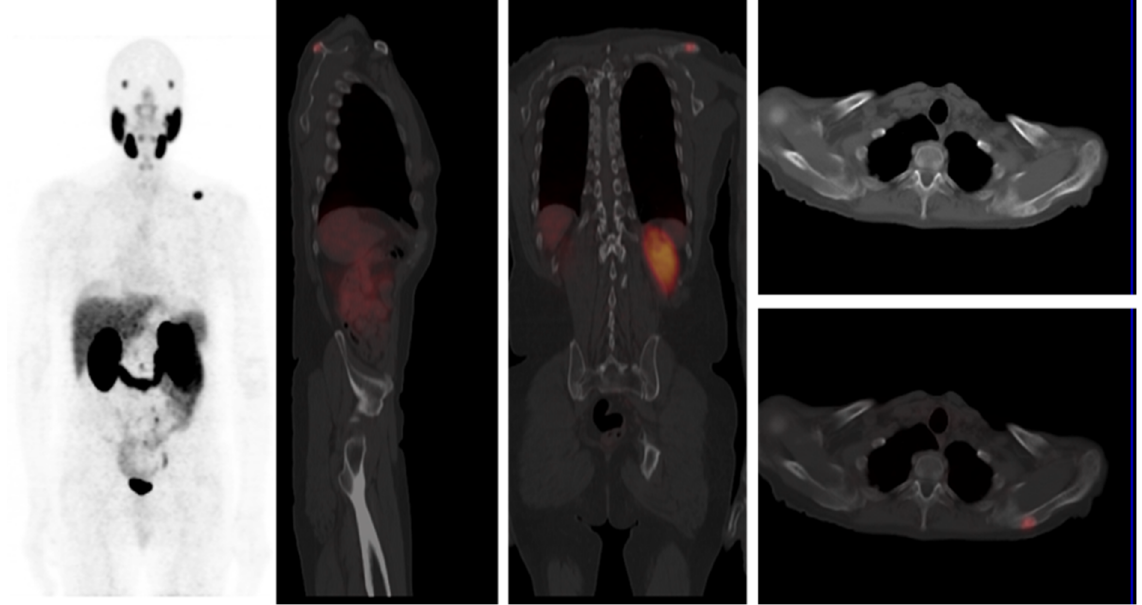
Figure 4. A 68-year-old male known with adenocarcinoma of the prostate, Gleason 4+3. He had radical prostatectomy for local radical therapy. Ga-PSMA-11 PET/CT was obtained at serum PSA level of 3.46 ng/mL to localize the site of disease recurrence. Images obtained from his scan show intense tracer uptake in the left scapula consistent with a solitary skeletal site of extra-pelvic recurrence of prostate cancer. Multiple focal areas of increased tracer accumulation seen in the maximum intensity image (right image) on the left side of the midline in the abdominopelvic area are consistent with urine within the left ureter.